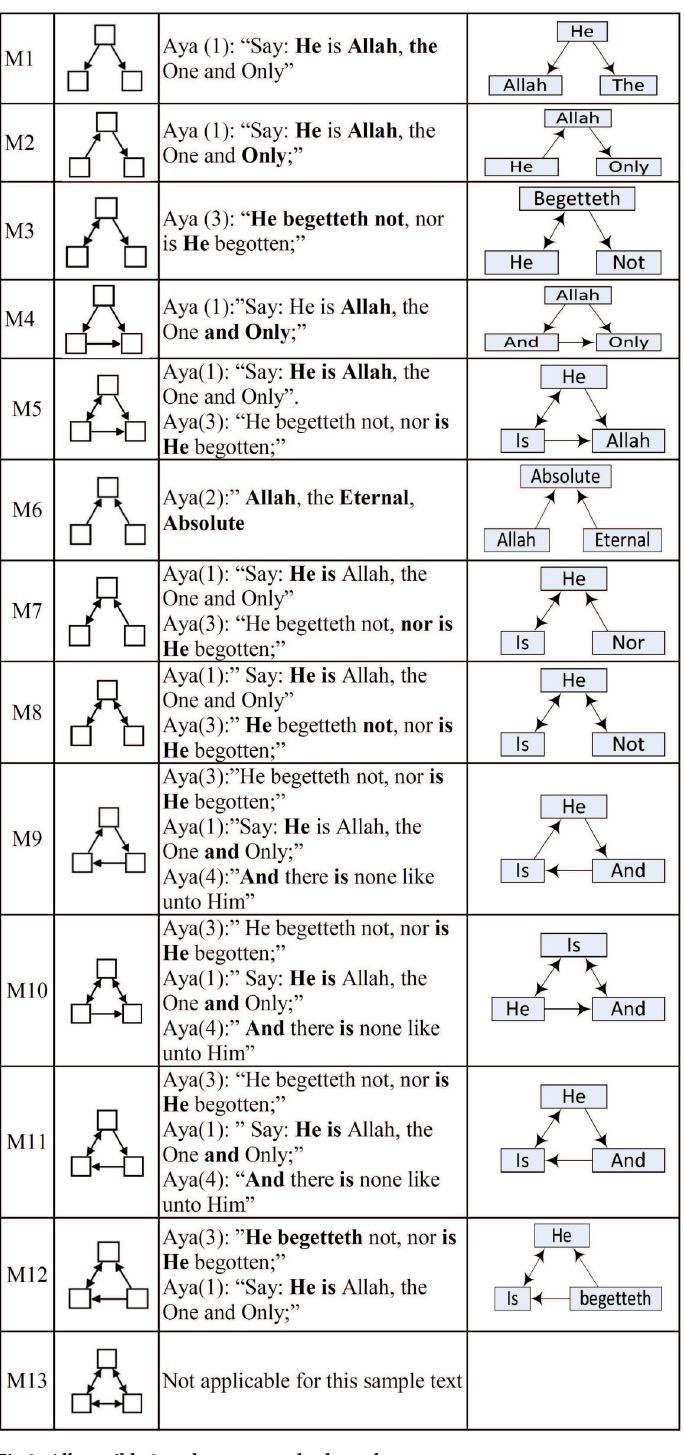
Fig 2. All possible 3-nodes connected